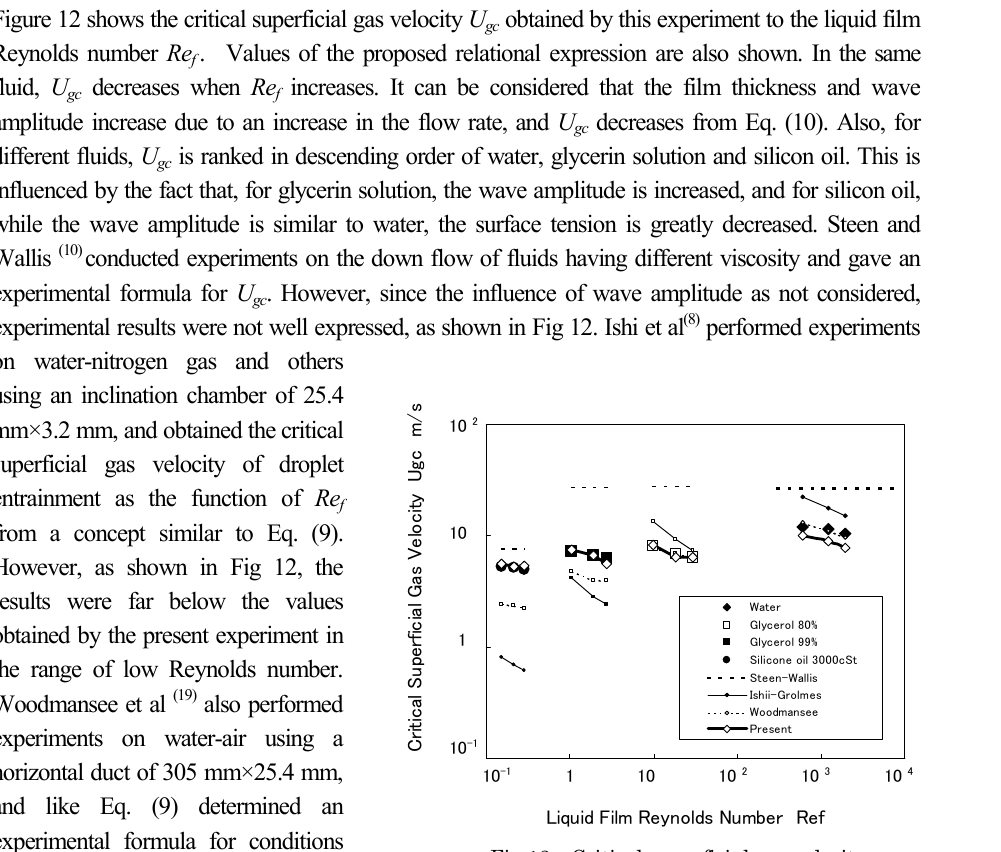
Fig.12 Critical superficial gas